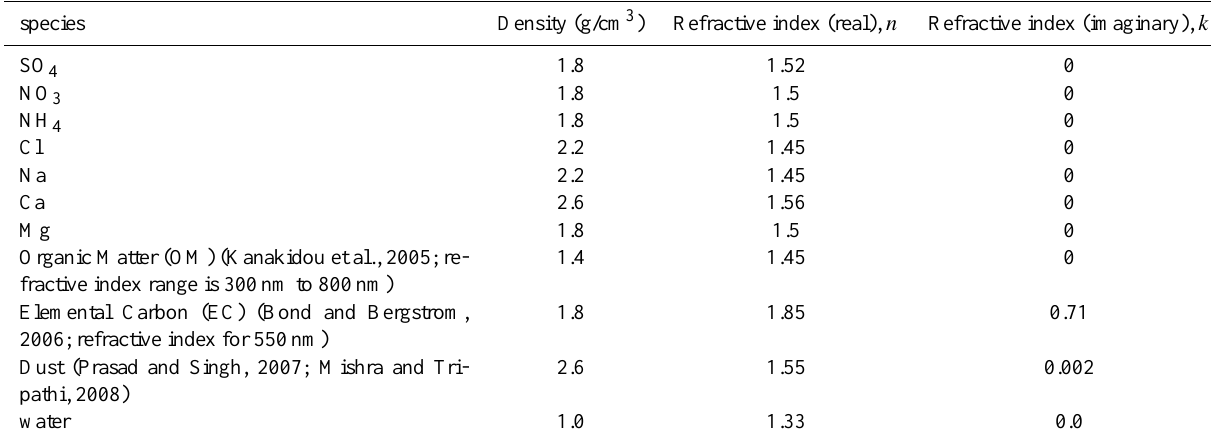
Table 1. Assumed densities and refractive indices ( n + i k) of the indicated species. Unless otherwise noted, the refractive indices are for a wavelength of